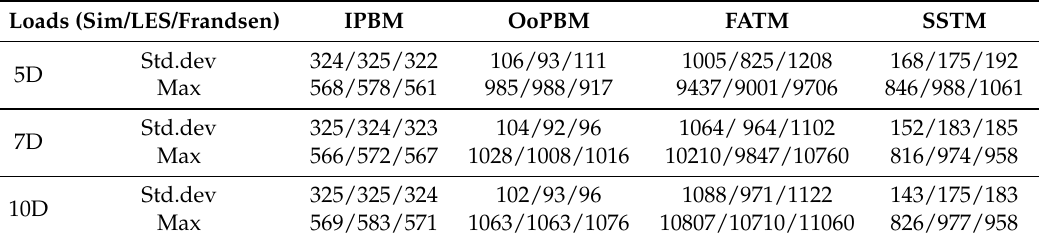
Table 16. Standard deviation and maximum of various turbine loads from stochastic vs. LES waked wind fields vs. Frandsen wake